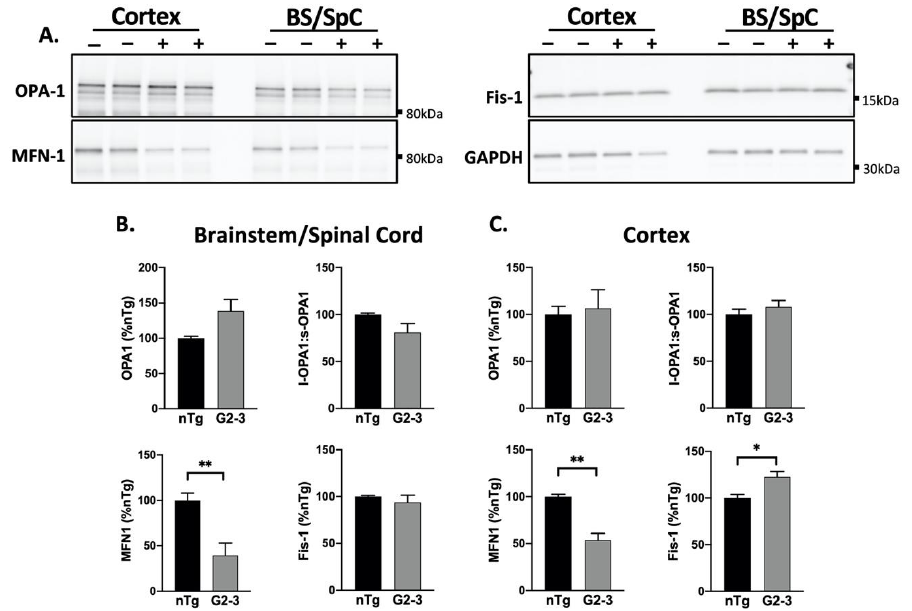
Figure 4. Decreased MFN1 levels with A53T mutant human α S expression in vivo. ( A ) Western blot of mitochondrial dynamics proteins in the total brain lysate of nTg (−) and Tg (+) animals. ( B , C ) A quantification of immunoblots shown in ( A ) normalized to GAPDH, show a decrease in MFN1 levels in the BS/SpC and the Ctx ( p = 0.0074, p = 0018, respectively) of the TgA53TG2-3(G2-3) samples compared to the nTg samples. In the G2-3 cortex, Fis-1 levels were also increased ( p = 0.0145), per the unpaired t -tests with Welch’s correction ( n = 5 per group, mean ± SEM). (* p < 0.05, ** p < 0.01).